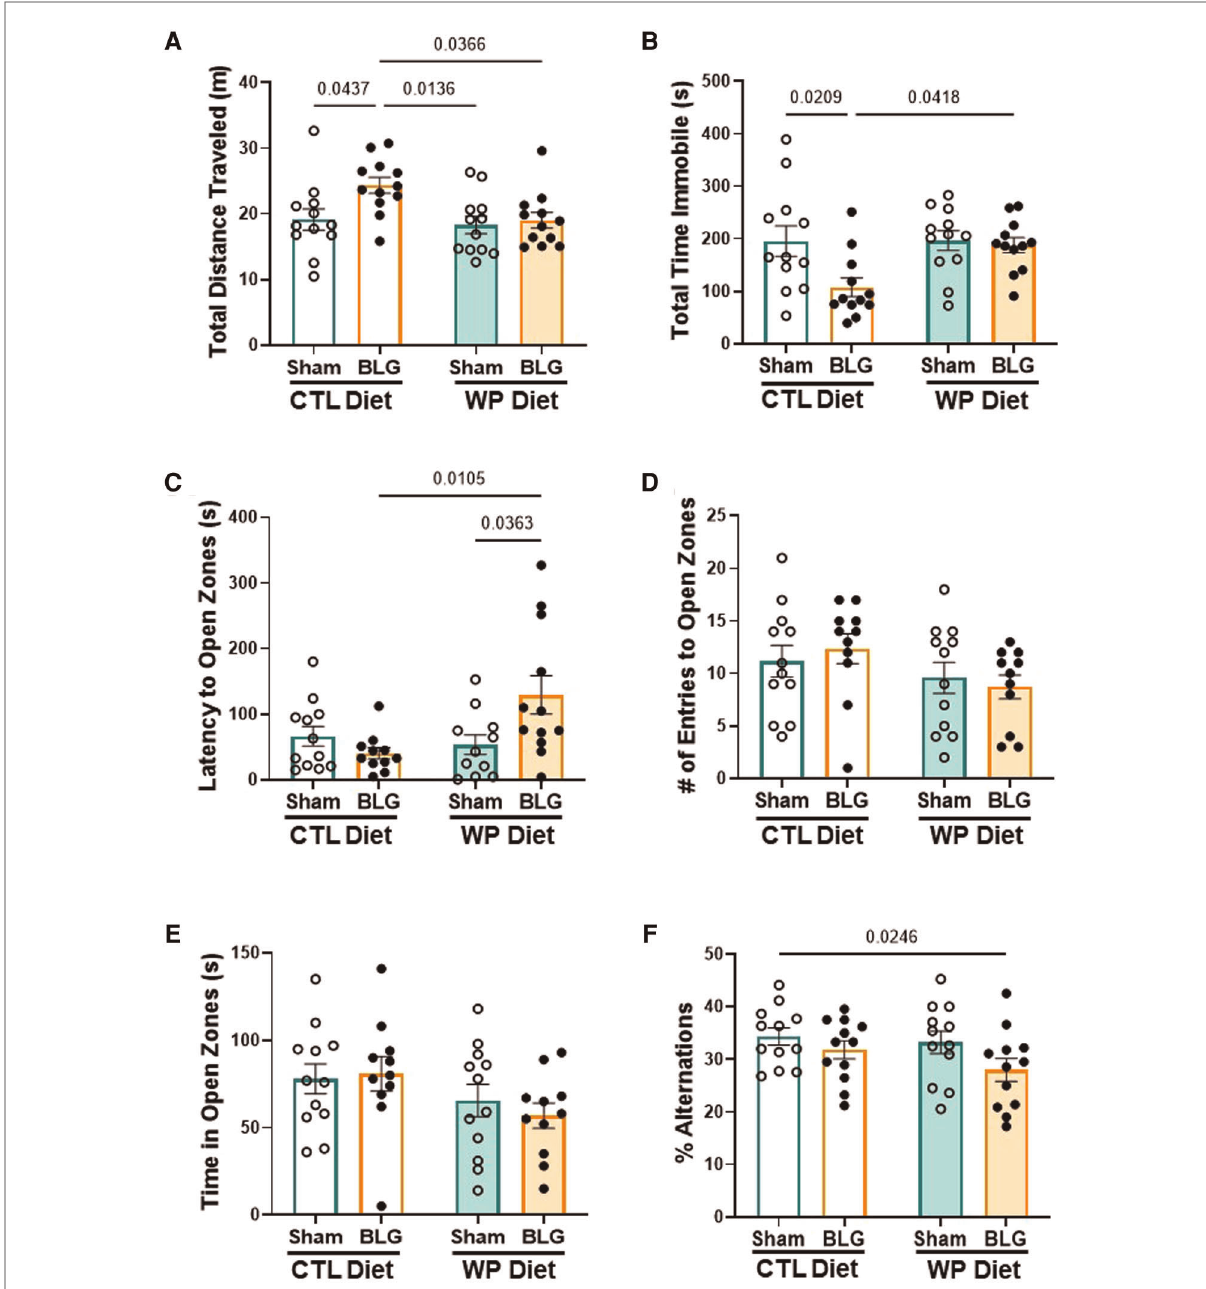
FIGURE 3 Behavioral assessments. All mice were subjected to behavioral tests during the last week of the 3-month exposure phase. Total distance traveled ( A ) and total time immobile ( B ) in the OFT, latency to enter the open zone ( C ), the number of entries to the open zone ( D ) and total time spent in the open zone ( E ) on the EZM, and the percentage of successful arm-entry alternations (% alternations) during the CMT ( F ) are compared among the experimental groups. Values indicate the group average±SEM. Signi fi cant p -values are shown. Two-way ANOVA with Fisher ’ s LSD, n =12 per group. Two outliers were identi fi ed by the ROUT (Q=1%) for the latency to enter open zones and excluded from the fi nal analysis ( C ). Two mice fell off the apparatus during the EZM test and thus were removed from the analysis of the number of entries to open zones ( D